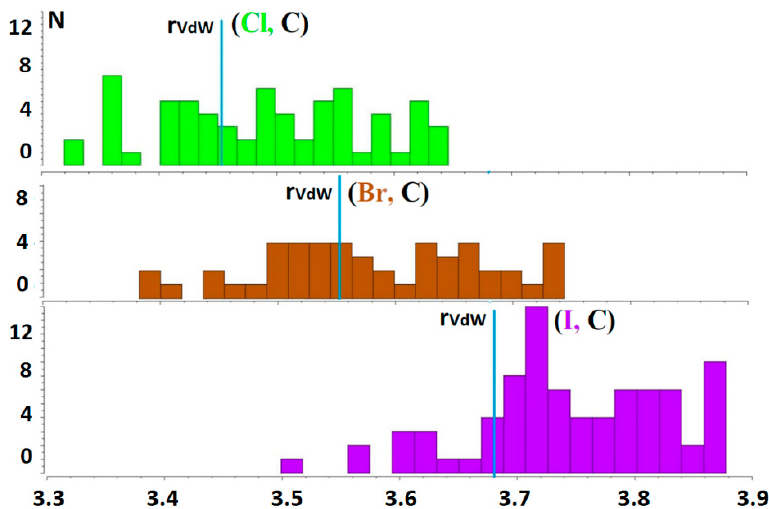
Figure 1. The distribution of the Hal − ··· CH 3 –Y interactions in crystals for Cl − (green), Br − (brown), I − (violet); the blue lines mark the sum of van der Waals radii.